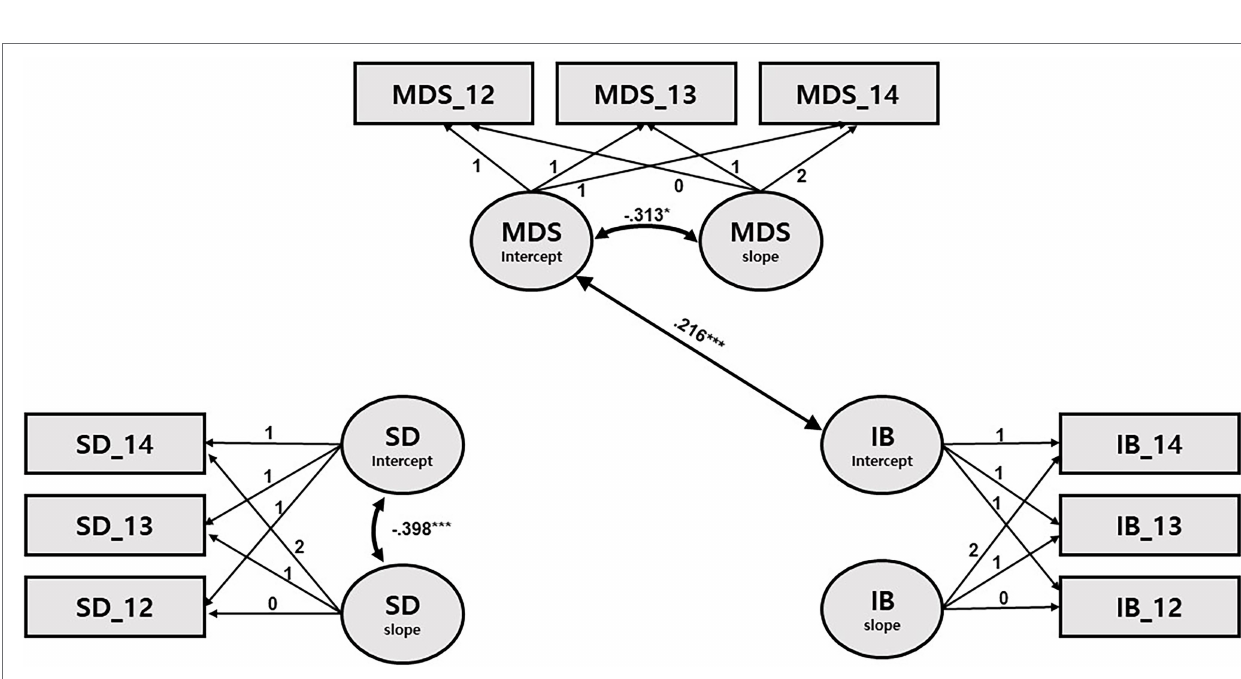
FIGURE 2 | Path diagram for latent growth modeling of sleep duration, internalizing behaviors, and maternal depressive symptoms. SD: sleep duration; IB: internalizing behaviors; and MDS: maternal depressive symptoms. Only significant path coefficients are shown. * p < 0.05, ** p < 0.001, and *** p <